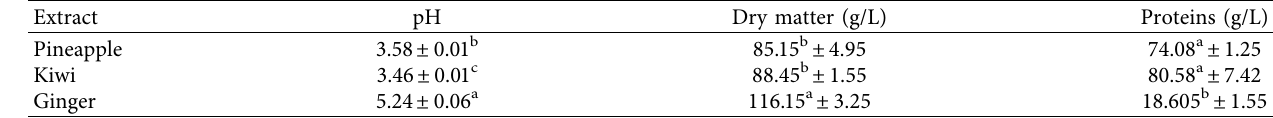
Table 1: Physicochemical characterization of the three enzymatic